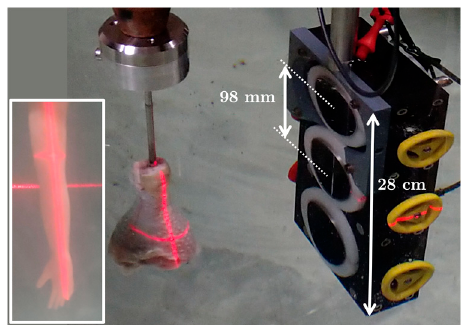
Figure 4. (Inset on the left) Newborn arm phantom. Cross-sections were chosen in areas 6 mm and 14 mm from the hand at the level of the laser cross. (Left part) Complete fresh chicken drumstick containing skin, fat, muscle, tibia, and fibula. Cross-sections were chosen in the proximal area 25 mm from the upper tibio-fibular joint at the level of the laser cross. (Right part) Three-frequency linear transducer array; f O = 500 kHz (bottom), 1 MHz (middle), 2.25 MHz